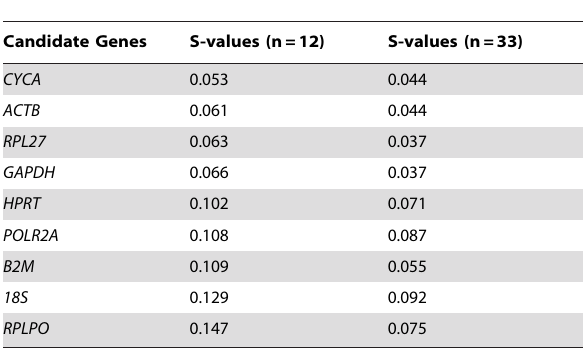
Table 3. Gene stability (S) values calculated by